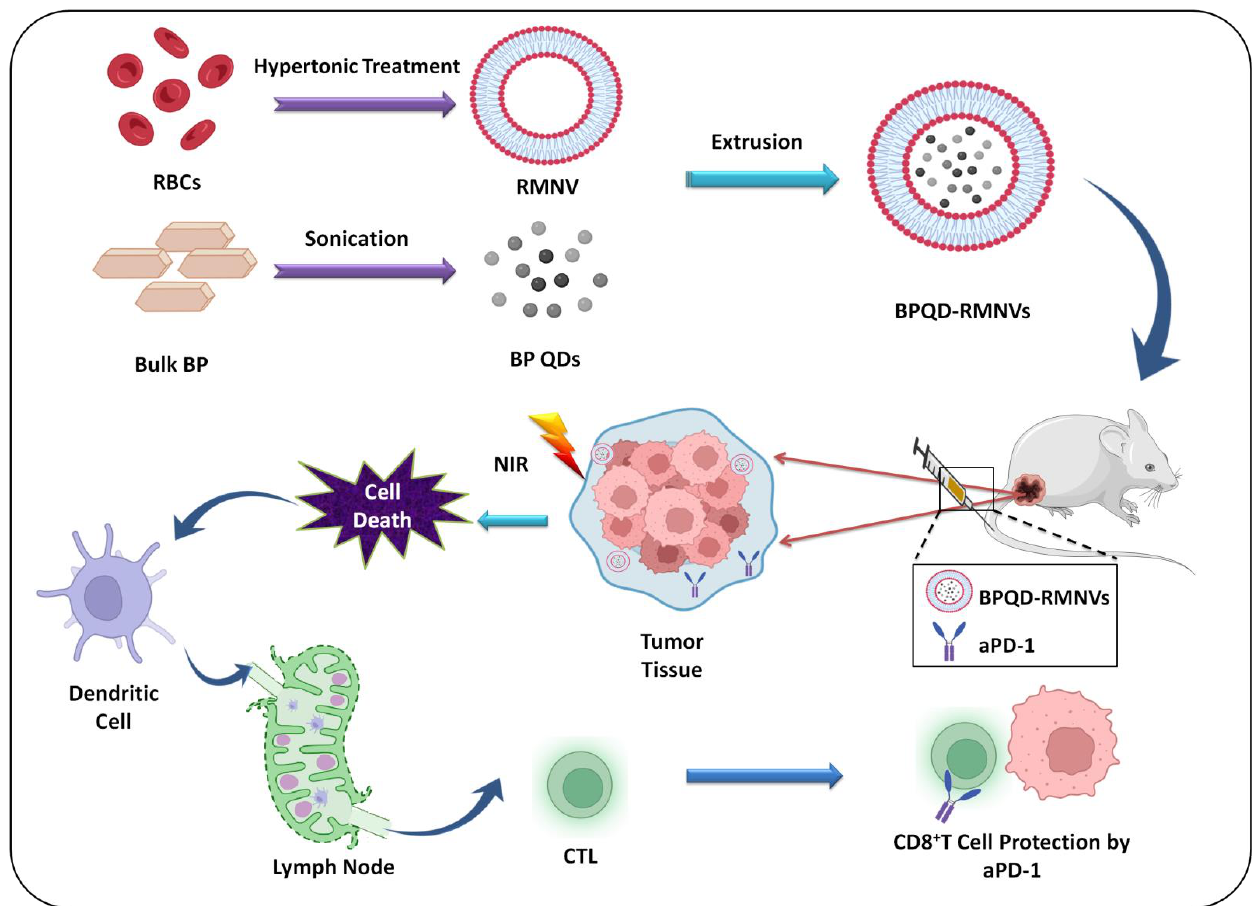
Figure 4. Diagrammatic representation of synthesis and photothermal tumor immunotherapy shown by BPQD-RMNVs and aPD-1. by BPQD-RMNVs and